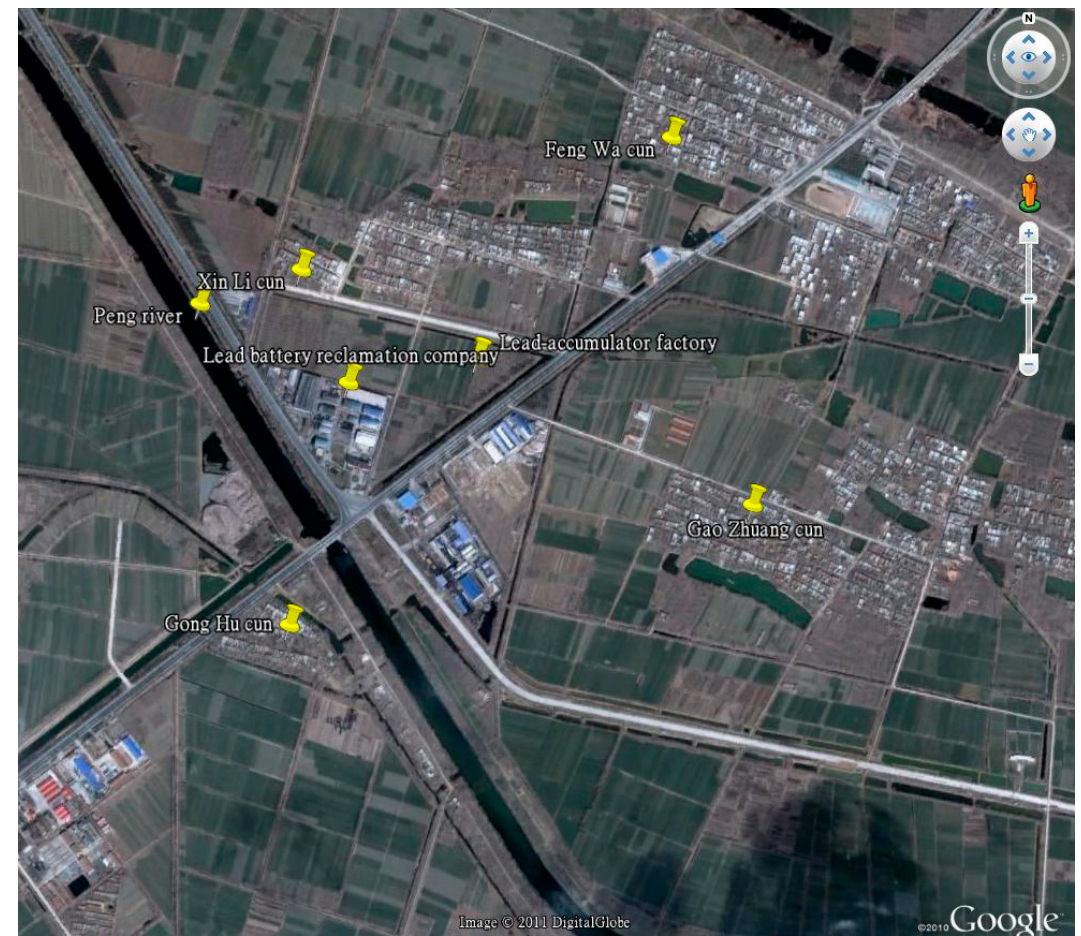
Figure 1. Map of lead battery recycling plant under investigation and sampling sites.